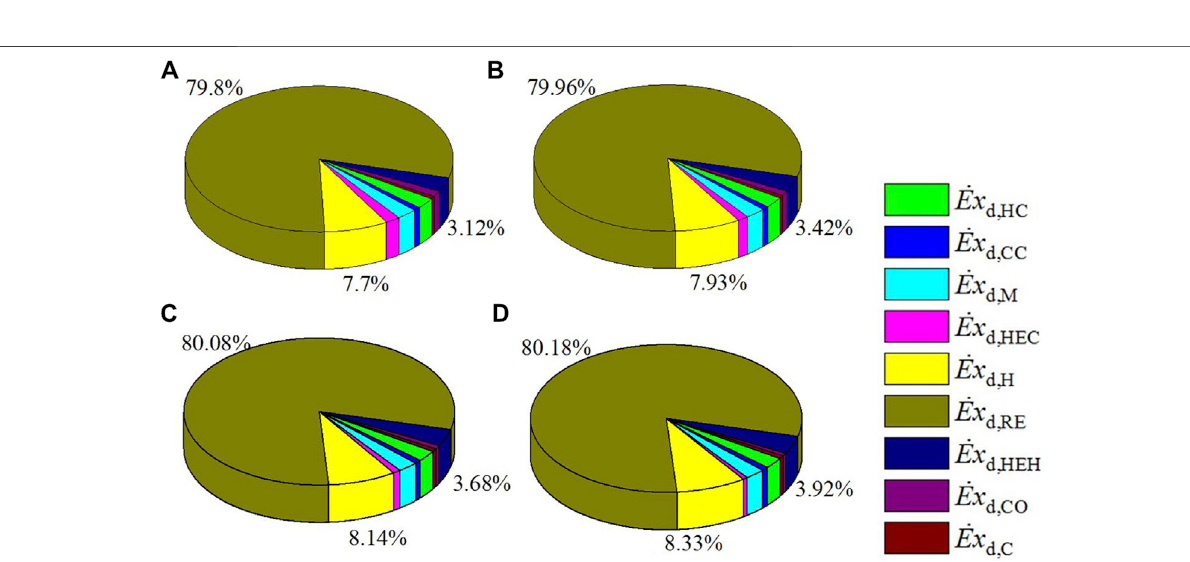
Frontiers in Energy Research |